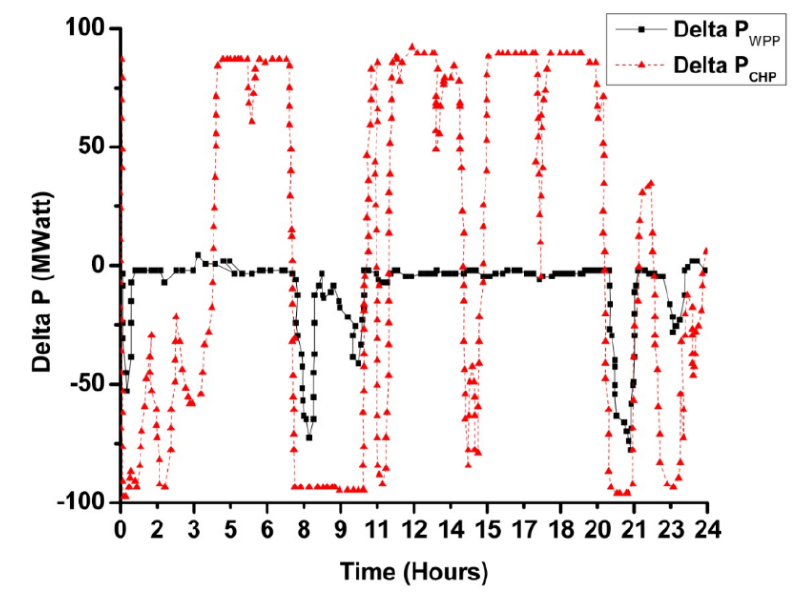
Figure 6. Automatic Generation Control